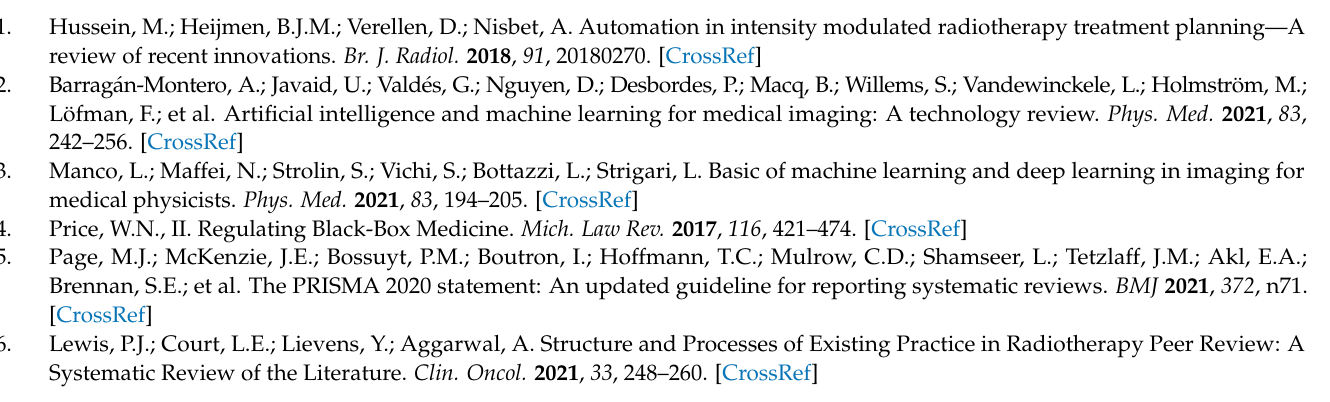
classification according to the study main aims and AI subgroups (i.e., type of methods); Table S2: List of excluded papers and reasons for exclusion from quantitative